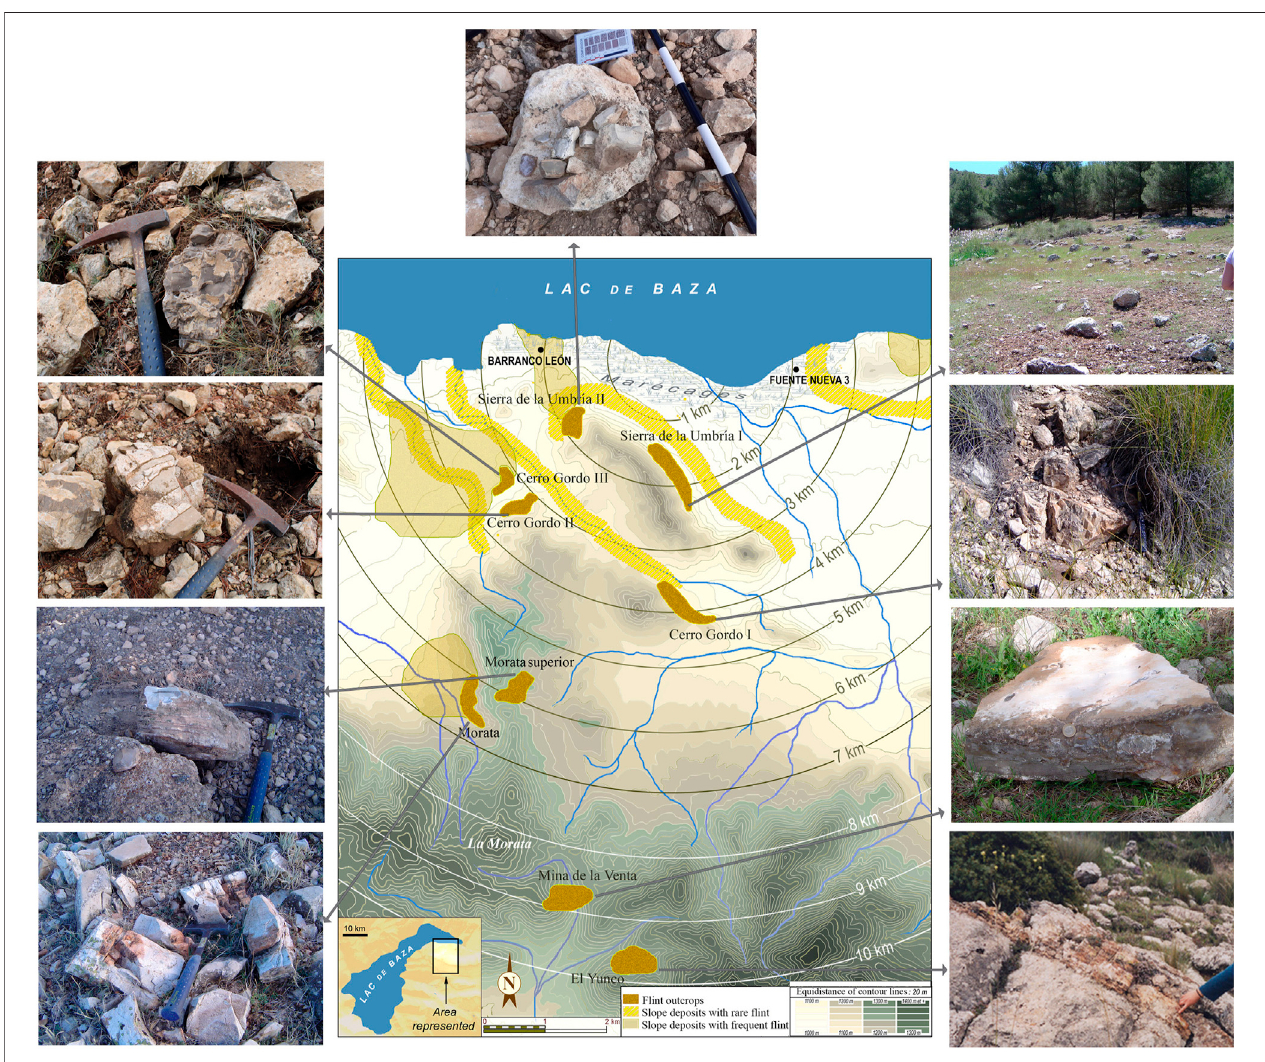
FIGURE 4 | Map showing the location of the fl int outcrops and block morphology (modi fi ed after Toro-Moyano et al., 2010).